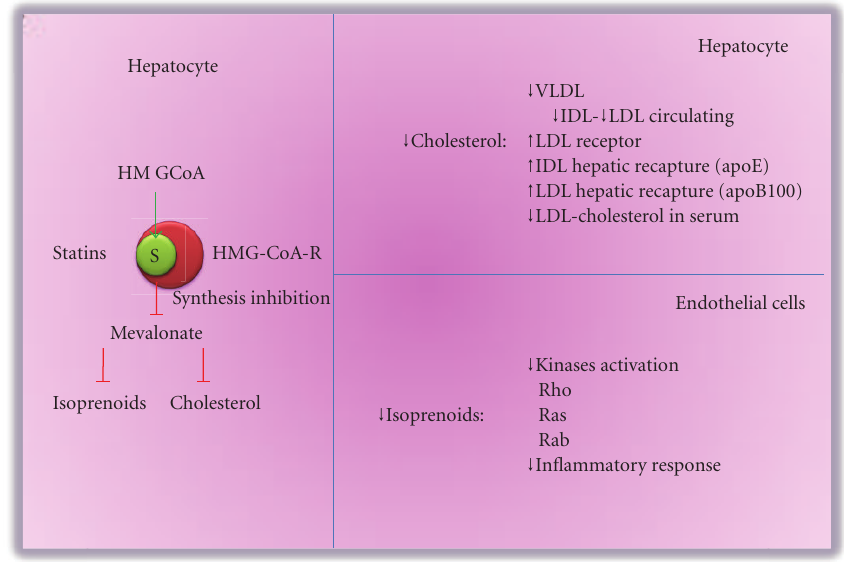
Figure 2: Statins reduce cholesterol, and isoprenoids synthesis. The statins inhibit HMG-CoA-R and block the synthesis of mevalonate, cholesterol, and isoprenoids. In the hepatocyte, the reduction in cholesterol synthesis determines a reduction in VLDL synthesis and increase in the synthesis of LDL-R; thus, the reduced production of VLDL, IDL, and LDL and increased elimination of circulating IDL, and LDL, explain the reduction in LDL concentration. In the endothelial cells the reduction in the synthesis of isoprenoids determines a reduction of the inflammatory response mediated by inactivation of smgs from di ff erent families (Rho, Ras, Rab).